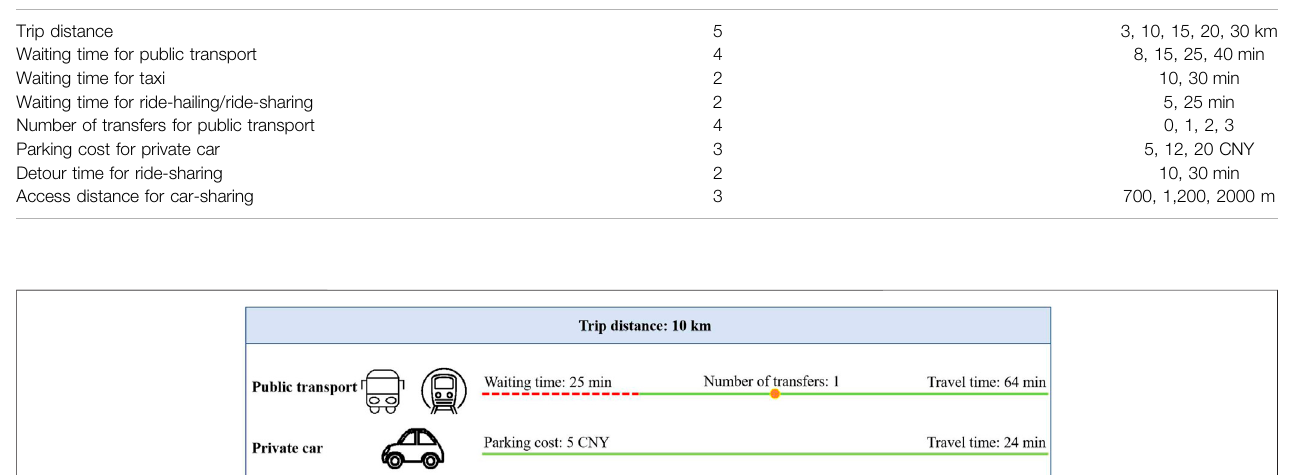
TABLE 1 | Levels for the SP survey. Variable